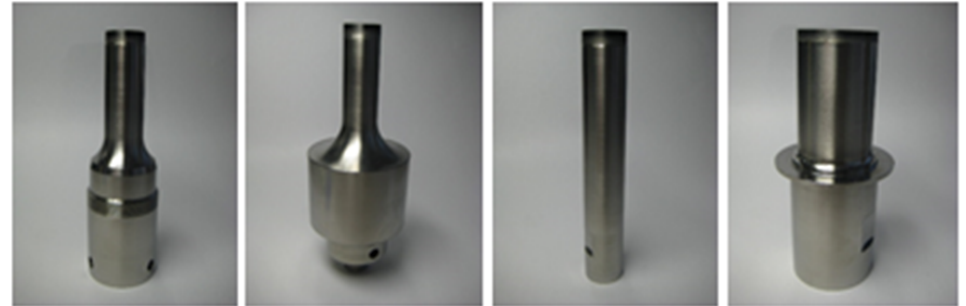
Figure 42. Various types of ZrO 2 /Ti system FGMs horn tip tools for ultrasonic